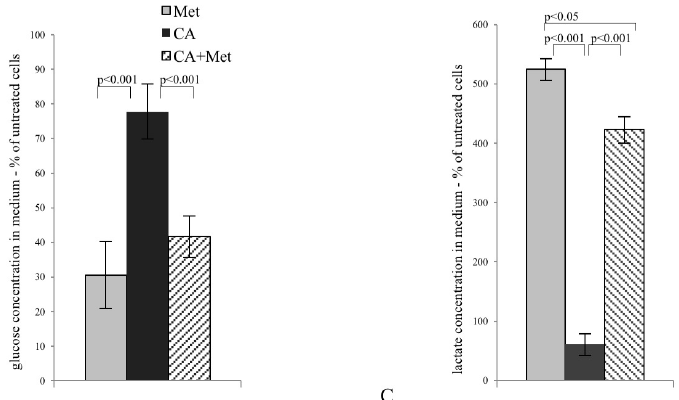
Figure 2. CA activates AMPK in HTB-34 cells along with increasing pyruvate decarboxylation via PDH complex and decreasing glucose consumption and lactate production. Immunoblot analysis (the details described in Materials and Methods) reveals enhanced phosphorylation of AMPK on T 172 residue by CA alone and Met/CA co-treatment along with activation of AMPK downstream ACC-1 and decrease of ATP content ( A ); Met and CA have slight, opposite effect on glucose uptake via GLUT-1. CA and Met/CA cause loss of PFK-2 activity. CA increases PDH-E1 α phosphorylation on S 293 and inhibits PDH kinase (PDK) activity facilitating pyruvate flux via PDH complex. Note the opposing effect of Met on PDH phosphorylation (caused by PDK activation) compared with CA and recovery of metformin-inhibited PDH complex by co-treatment with CA. CA, Met, and Met/CA treatment has no effect on Glutaminase (GLS) expression ( B ); For Western blot analyses β -actin was used as the protein loading control, band intensities were quantified by densitometry analysis and expressed relative to the control (* p < 0.05 vs. untreated control). CA decreases glucose consumption and lactate release into culture medium ( C ) after 24 h of incubation and attenuates the effect of Met. CA was used at 100 µM and Met at 10 mM for 24 h. Experiments were repeated three times with similar results.